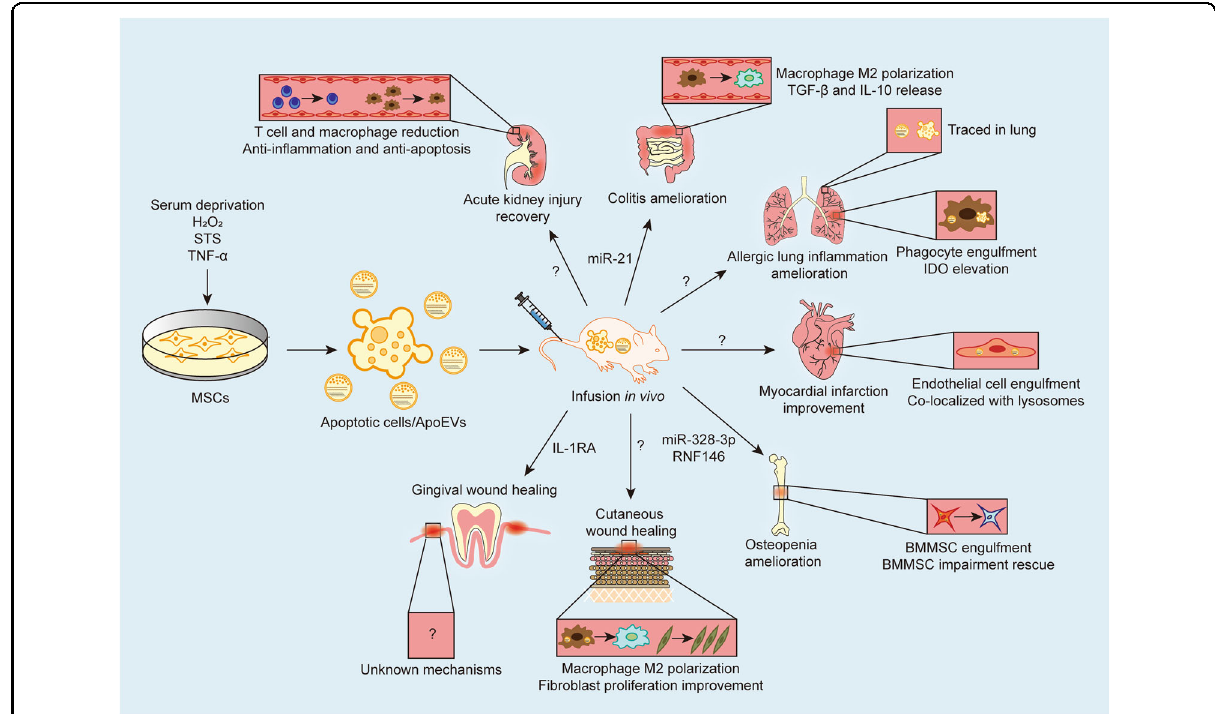
Fig. 3 Apoptosis and apoEV contribution to the therapeutic effects of MSCs. Under the multiple exogenous apoptotic stimuli, MSCs in culture can be induced to apoptosis to form apoptotic cells and apoEVs, which are collected and infused to various disease models. ApoEVs transplanted or released by infused apoptotic cells have been demonstrated to carry bioactive proteins and miRNAs to recipient cells for tissue homeostasis maintenance and immunoregulation. For examples, infused apoptotic cells and apoEVs are traced in lung and engulfed by phagocytes, which possess potent capacities of immunomodulation in in fl ammatory insults. ApoEVs regulate the number of immune cells and promote macrophage M2 polarization in multiple diseases including acute kidney injury, the colitis, allergic lung in fl ammation, and cutaneous wound healing. Apoptotic cells and apoEVs can also be engulfed by endogenous MSCs and endothelial cells, contributing to the rescue of impaired stem cells and tissue regeneration. While the therapeutic effects of apoptotic cells and apoEVs are remarkable, the mechanisms underlying molecular delivery and potential interplays between donors and recipients remain